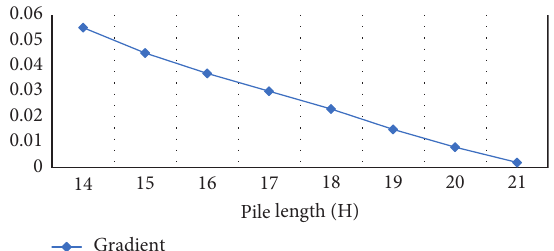
Figure 5: Inclination curves of ancient buildings with different pile lengths.